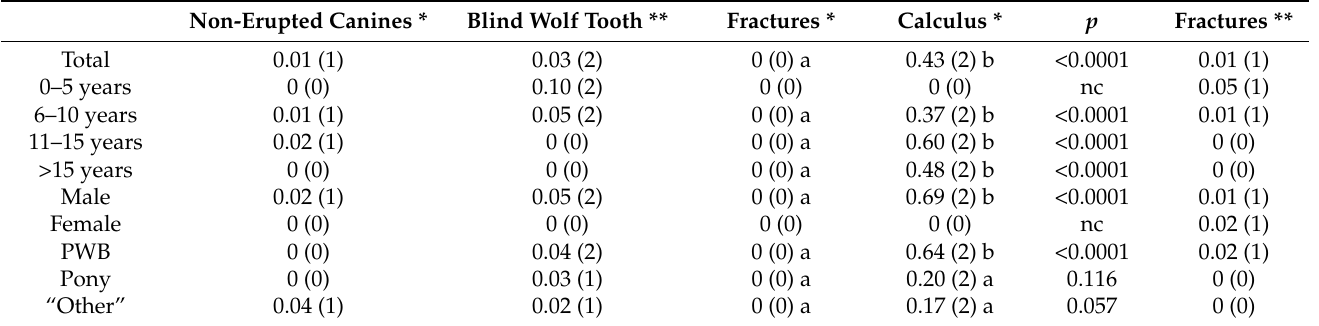
Table 7. The frequency distribution of malocclusions and dental diseases of canine * and wolf ** teeth in the total 7912 examined teeth of 206 horses.